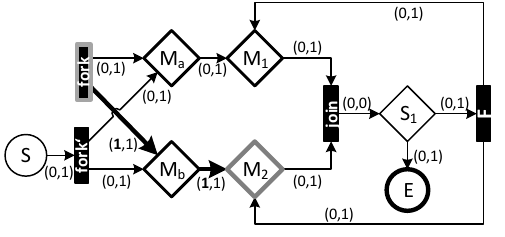
Figure 20. The flow network with respect to the fork node fork and the superfluous intersection ( M , join 2